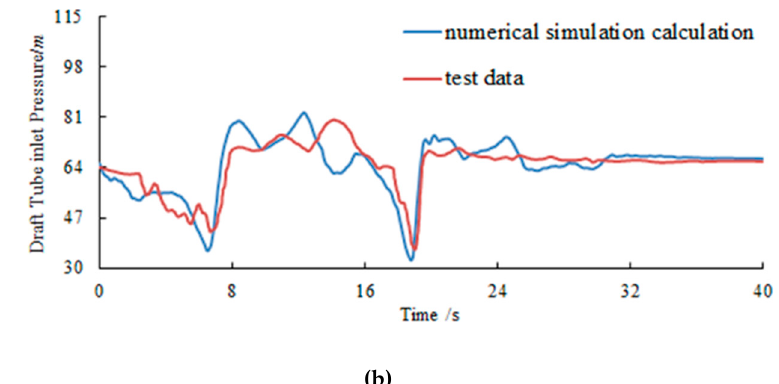
Figure 9. Comparison between the measured data and numerical simulation results of field load rejection test: ( a ) No. 2 spiral case pressure process line; ( b ) No. 2 draft tube inlet pressure process line. Table 5. Comparisons between the measured data and numerical simulation extremum.